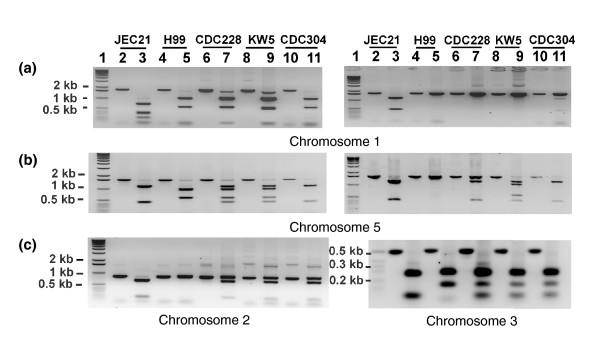
PCR-RFLP confirmation of the presence of serotype-specific chromosomes in three AD hybrid strains. Agarose gels are shown in which lane 1 for each contains size markers (1 kilobase [kb] ladder); lanes 2, 4, 6, 8, and 10 contain undigested PCR fragments; and the remaining lanes contain the same fragments after restriction enzyme digestion. (a) Digestion of PCR fragments (primers CNA01230 F/R) from chromosome (chr) 1 with AvaI (left panel) or StuI (right panel). (b) Digestion of PCR fragments (primers CNE04380 F/R) from chromosome 5 with TaqI (left panel) or HindIII (right panel). (c) Digestion of a PCR fragment (primers CNB01970 F/R) from chromosome 2 with NdeI (left panel) and a fragment (primers acidphos F/R) from chromosome 3 with TaqI (right panel).